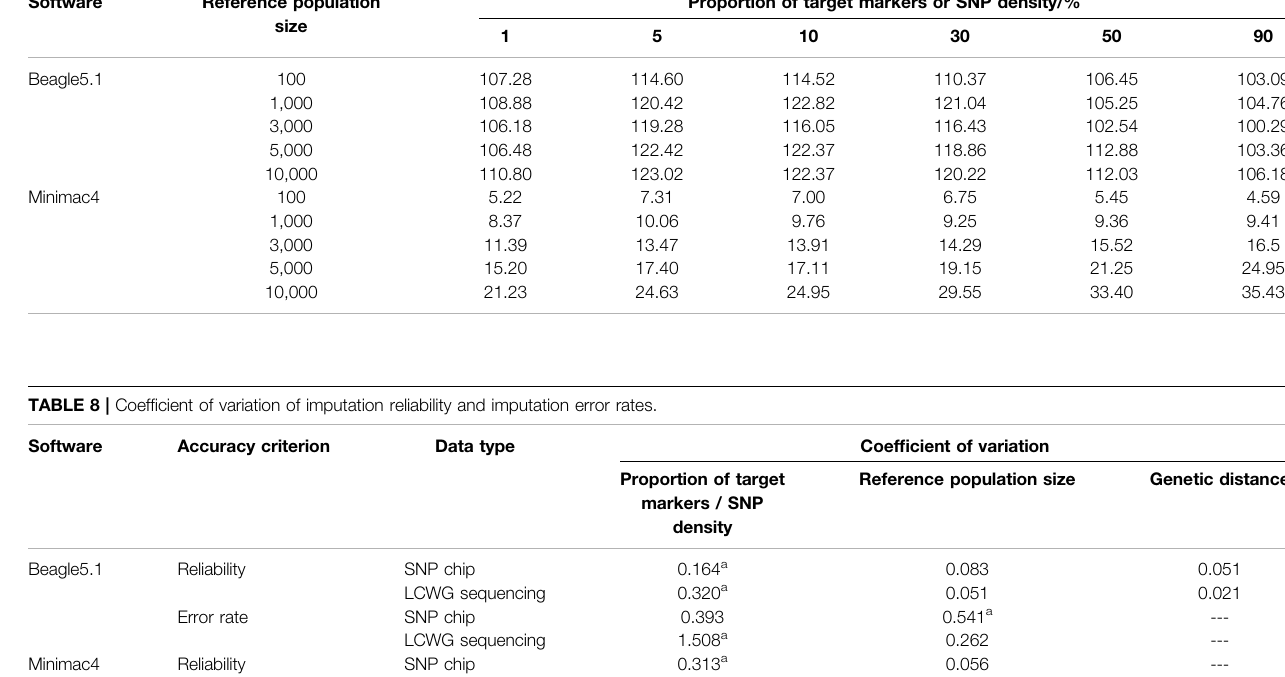
TABLE 7 | Runtime (min) to impute 10 Mb low-coverage whole-genome sequencing data with regard to software, reference population size, and proportion of target markers/SNP density. Software